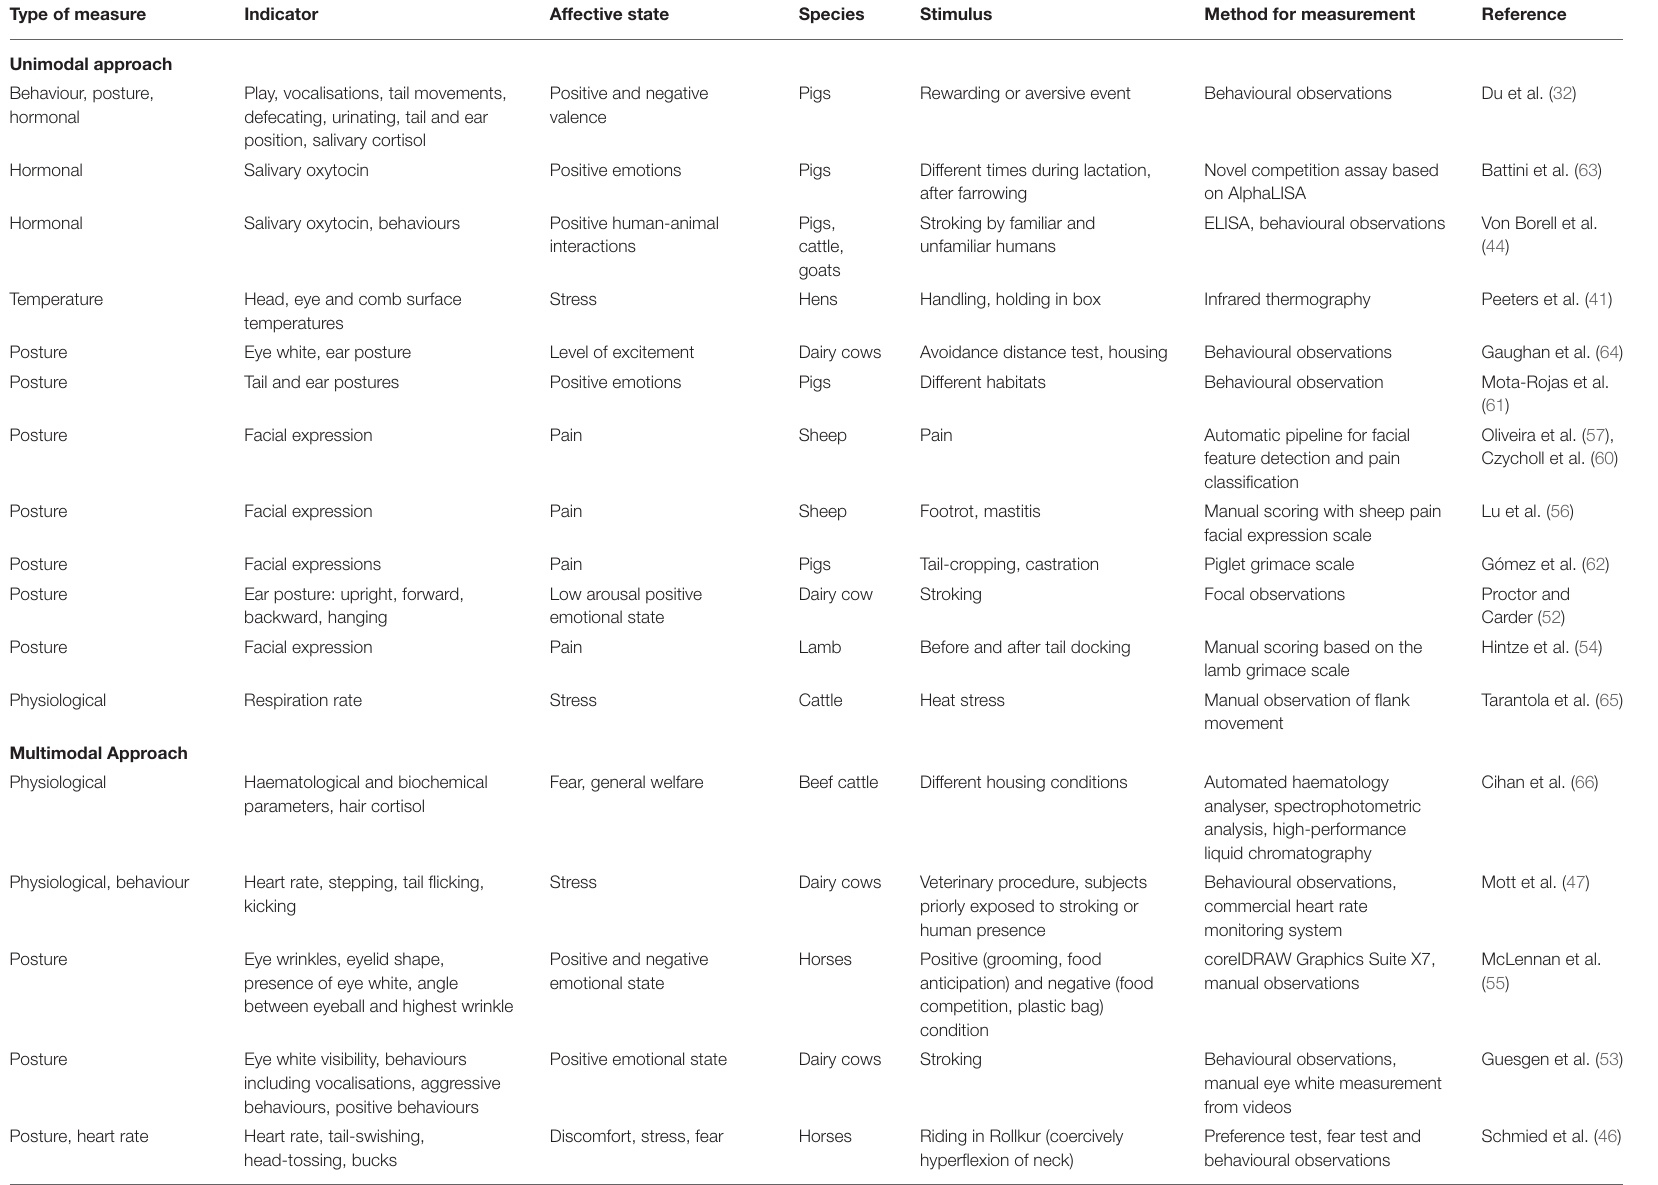
TABLE 1 | Summary of literature that measures indicators of affective states using unimodal and multimodal approaches in farm animals. Type of